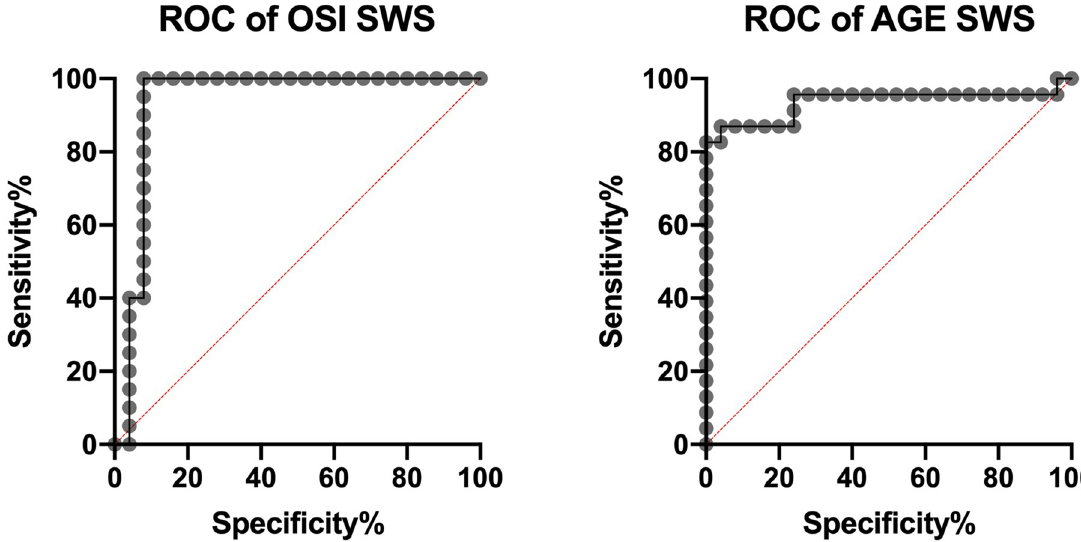
Figure 5. Receiver operating characteristic (ROC) analysis of OSI and AGE in stimulated whole saliva of patients with Alzheimer’s disease and the control group. AGE—advanced glycation end products; OSI— oxidative stress index; SWS—stimulated whole saliva. Pair of